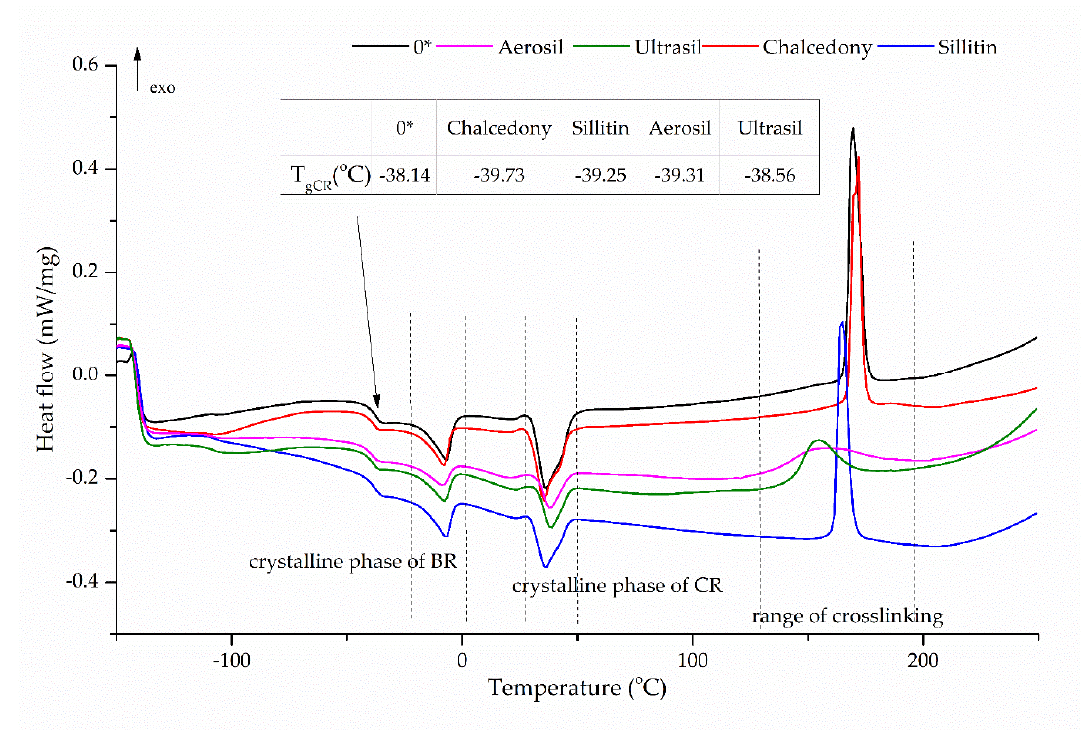
Polymers 2021 , 13 , x FOR PEER REVIEW Figure 2. DSC of unfilled and filled CR/BR/nano-Fe 2 O 3 blends. Figure 2. DSC of unfilled and filled CR/BR/nano-Fe 2 O 3 blends.